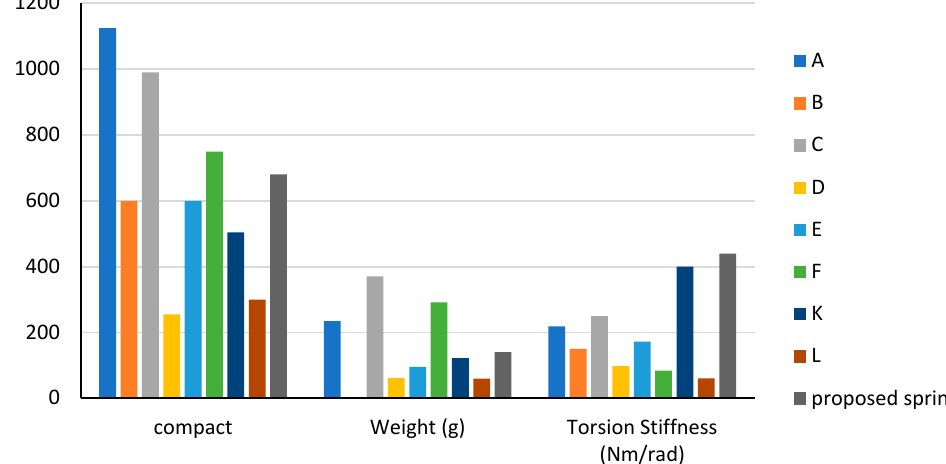
Figure 13. Spring characteristics of compactness, weight, and torsion stiffness. (A) [15]. (B) [10]. (C) [16]. (D) [7]. (E) [17]. (F) [18]. (K) [25,26]. (L) [22,23].